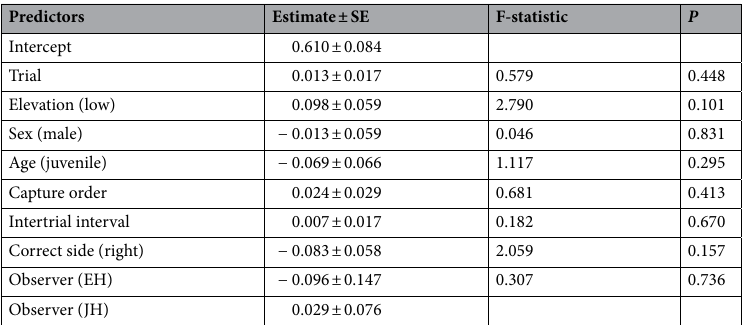
Table 2. Predictors of the log transformed ratio of errors made by birds (n = 59; n = 284 trials) across 5 proactive interference trials fitted with a linear mixed effect model with trial, capture order, intertrial interval (minutes), and elevation (high/low), sex (male/female), age (juvenile/adult) rewarded side of the tree (left/ right), and observer (EH, JH, AR) included as fixed effects. Bird ID was included as a random intercept.